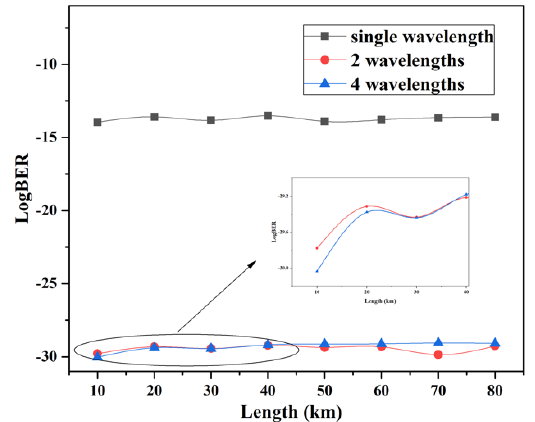
Figure 9. BER versus transmission distance of the hybrid OAM-DM-WDM-OFDM-PON system with different wavelengths.